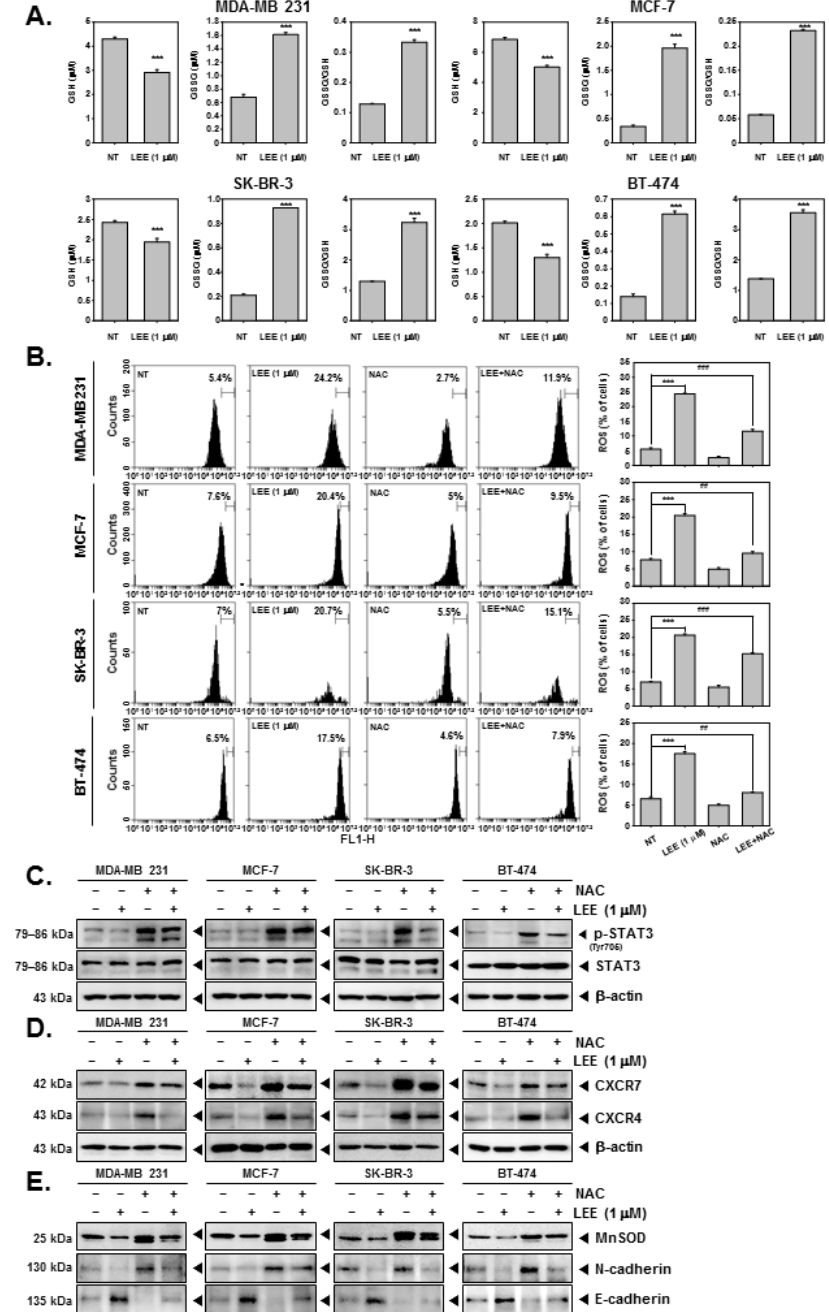
Figure 6. Induction of GSH/GSSG imbalance and ROS production by LEE. ( A ) The cells were treated with LEE, and GSH/GSSG was measured by GSH/GSSG assay. ( B ) The cells were pre-treated with LEE for 24 h, and stimulated by N-acetyl-l-cysteine (NAC) (3 mM) for 15 min. Then, ROS production was measured by flow cytometry. ( C ) Whole cell lysates were analyzed by Western blot analysis. Then, p-STAT3 and STAT expression levels were confirmed. ( D , E ) CXCR4/7 and EMT markers were evaluated by Western blot analysis. All the experiments were individually repeated at least thrice. ### p < 0.001 vs. LEE+NAC-treated cells, ## p < 0.01 vs. LEE + NAC-treated cells, and *** p < 0.001 vs. LEE-treated cells.